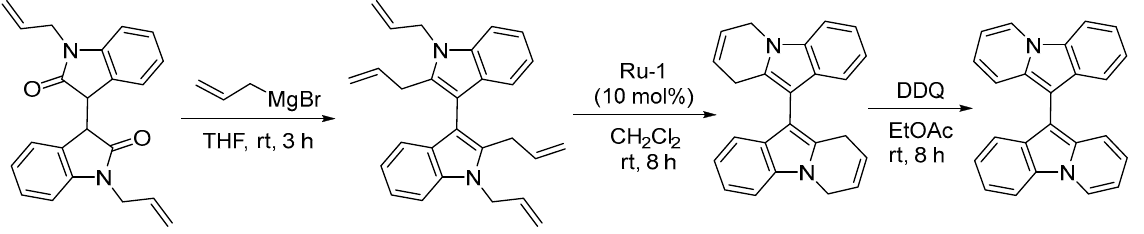
doindoles (Scheme 28)